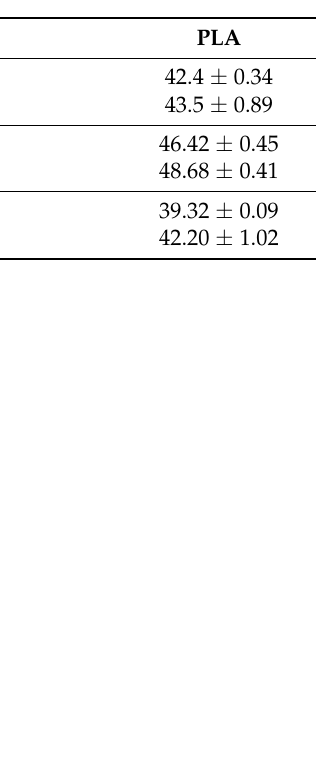
Table 3. Statistical analysis on the tensile results of AA5356 alloy and PLA.